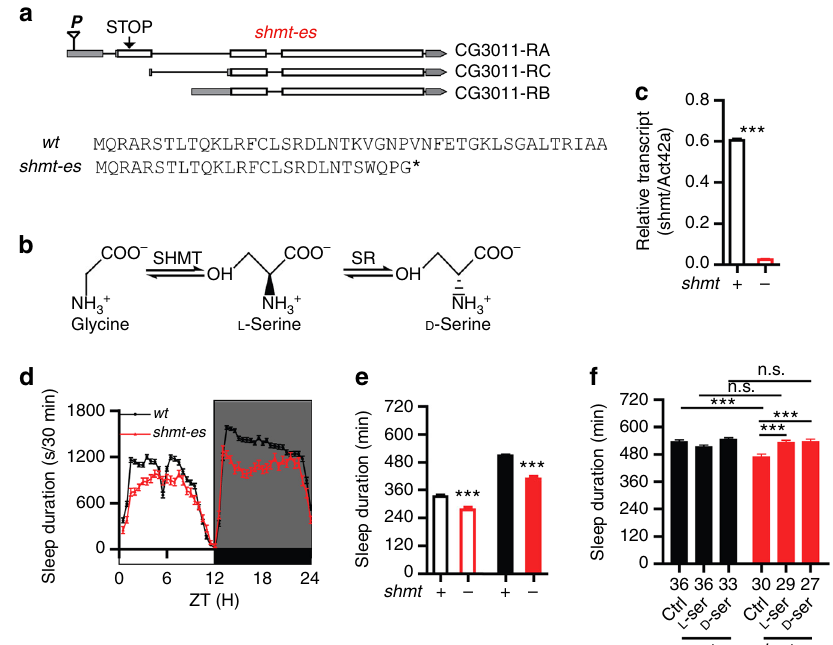
Fig. 1 Sleep phenotypes of shmt mutants. a A schematic representation of a point mutation leading to a premature stop codon in shmt (thus shmt-early stop or shmt-es ). Also shown is the amino acid sequences of the shmt-es mutant line used here. Single gRNA generated insertion and/or deletion (indel) in the shmt gene, introducing a frameshift and a stop codon (asterisk). b A diagram of D-Ser synthesis pathway. c mRNA level of isoform A shmt in shmt-es was signi fi cantly reduced. d Sleep pro fi les of shmt-es (red) ( n = 57) and wt (black) ( n = 236) fl ies, plotted in 30 min bins. White background indicates the light phase (ZT 0 – 12); shaded background indicates the dark phase (ZT 12 – 24). e Statistical analyses. Daytime and nighttime sleep durations were signi fi cantly reduced in shmt-es fl ies. In this and other fi gures, open bars denote daytime sleep and fi lled bars nighttime sleep. f Drug treatment of both L- and D-Ser rescued the nighttime sleep duration of shmt-es fl ies to the wt level. The number of fl ies used in the experiment was denoted under each bar. *** P <